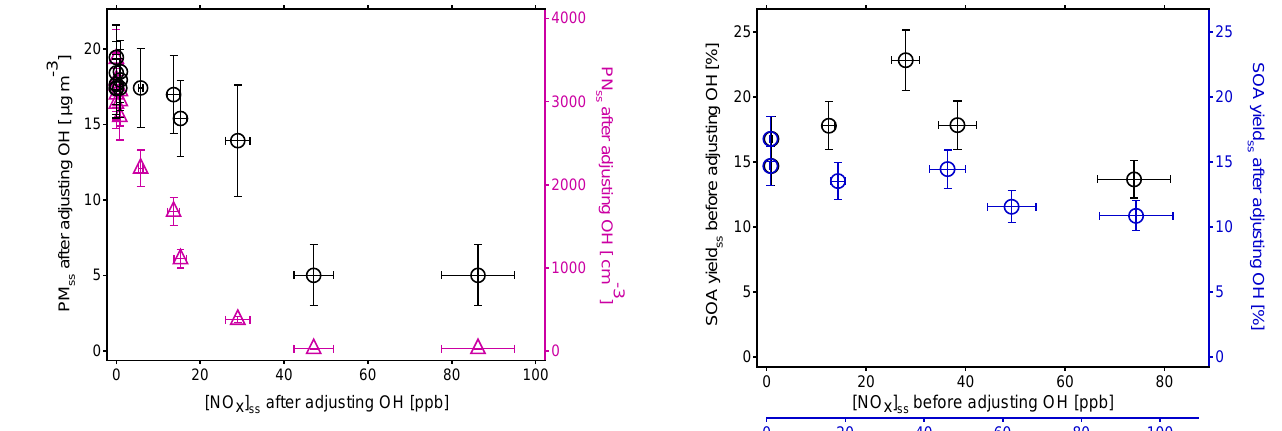
Figure 9. Comparison of measured particle mass and particle num- ber concentration after adjusting [OH] as a function of [NO x ] dur- ing steady state in the absence of seed aerosol. The error in particle number concentration was estimated to be ± 10%.